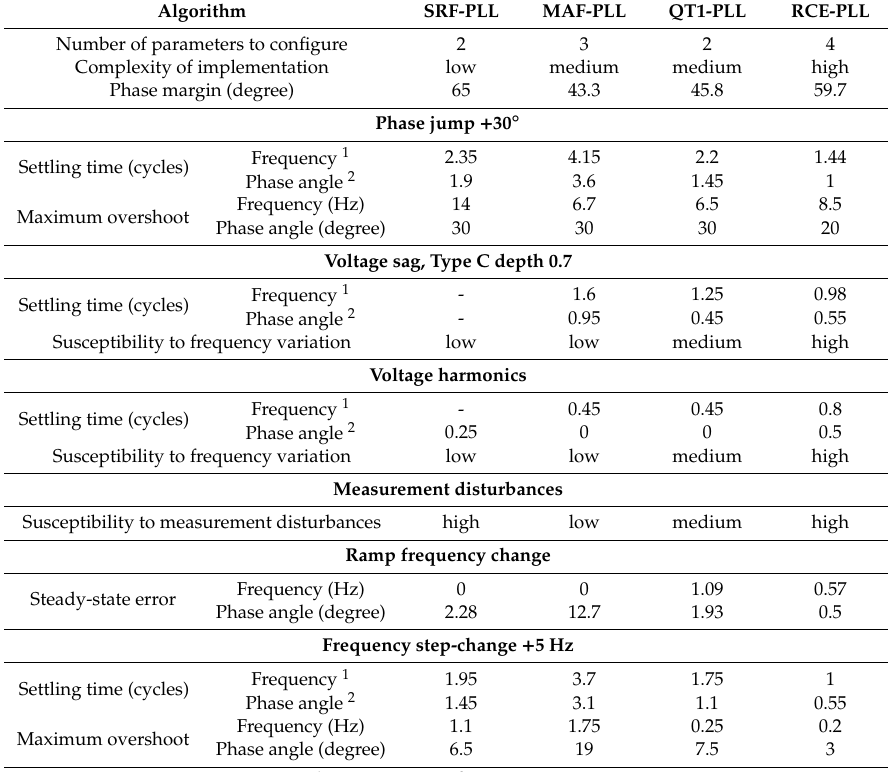
Table 4. Summary of results and implementation complexity.